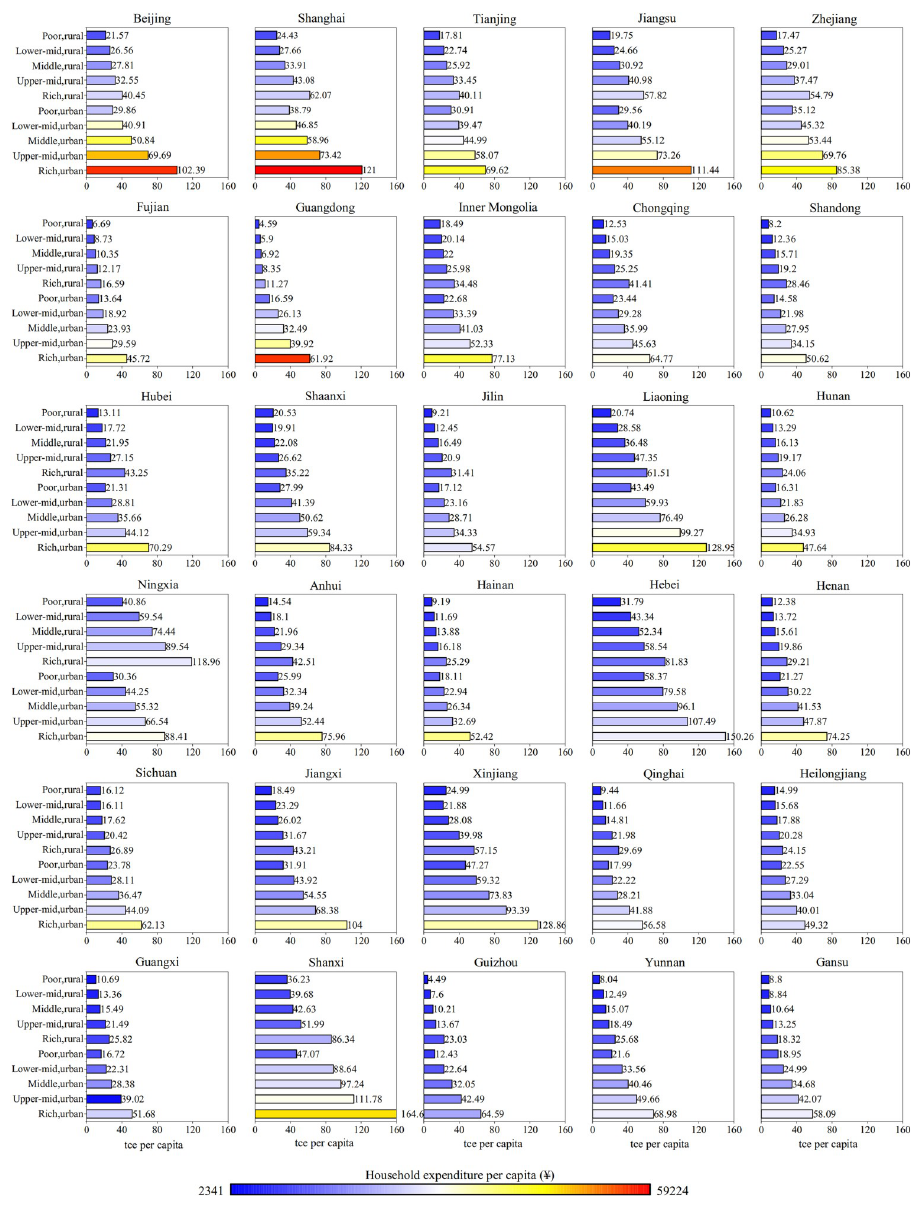
Fig 2. The PCHEF of 10 income groups in China’s 30 provinces in 2017. Bar colors correspond to household consumption expenditure per capita, with the wealthiest group in red and the poorest group in blue (see scale). All provinces are ranked by GDP per capita, from the wealthiest province (Beijing) in the first row, first column, to the poorest province (Gansu) in the sixth row, fifth column.